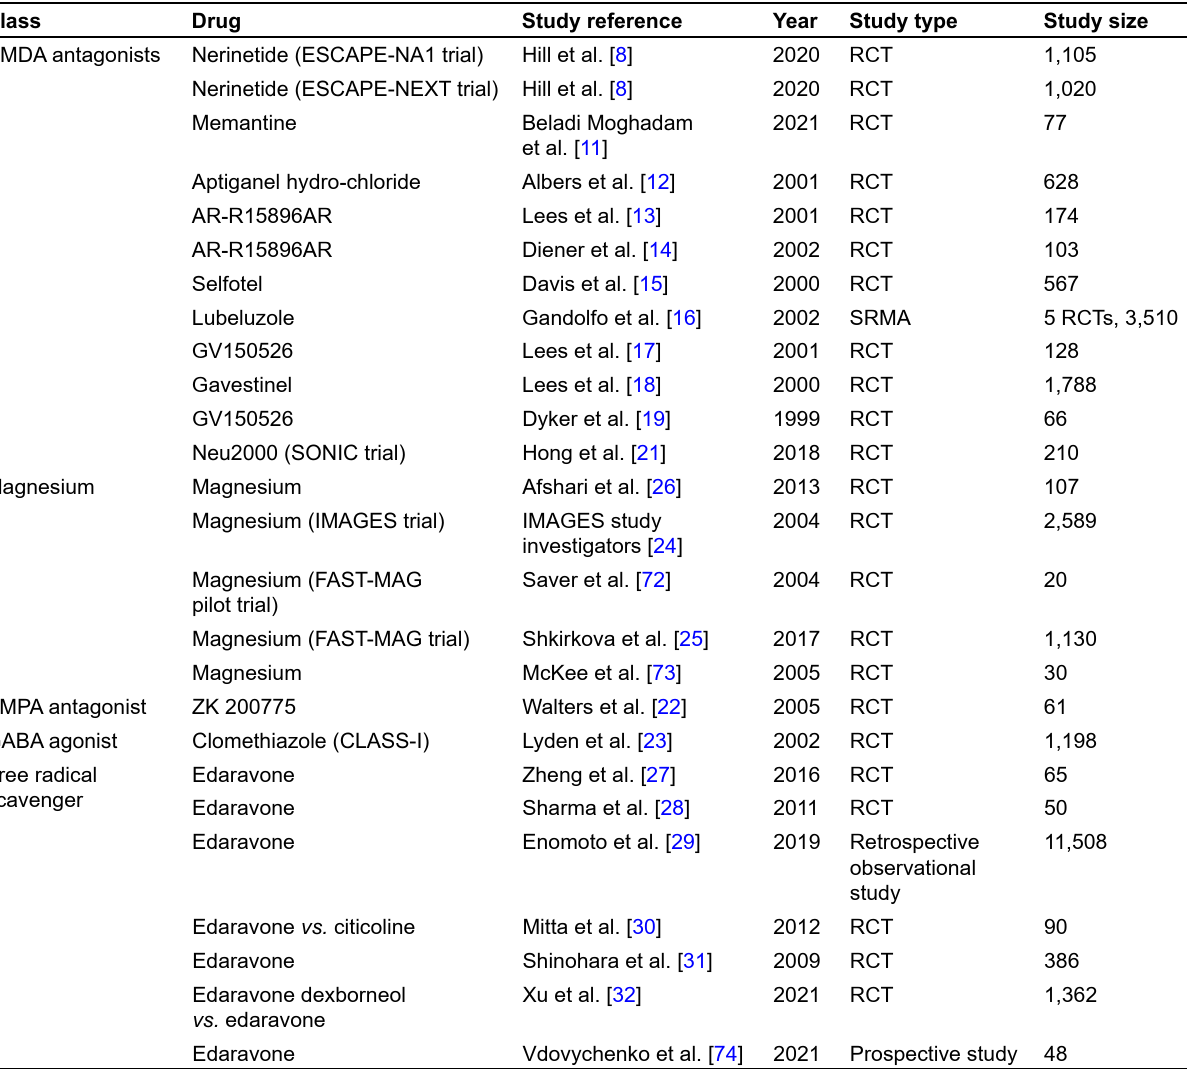
Table 2. Characteristics of human trials on neuroprotective agents in AIS